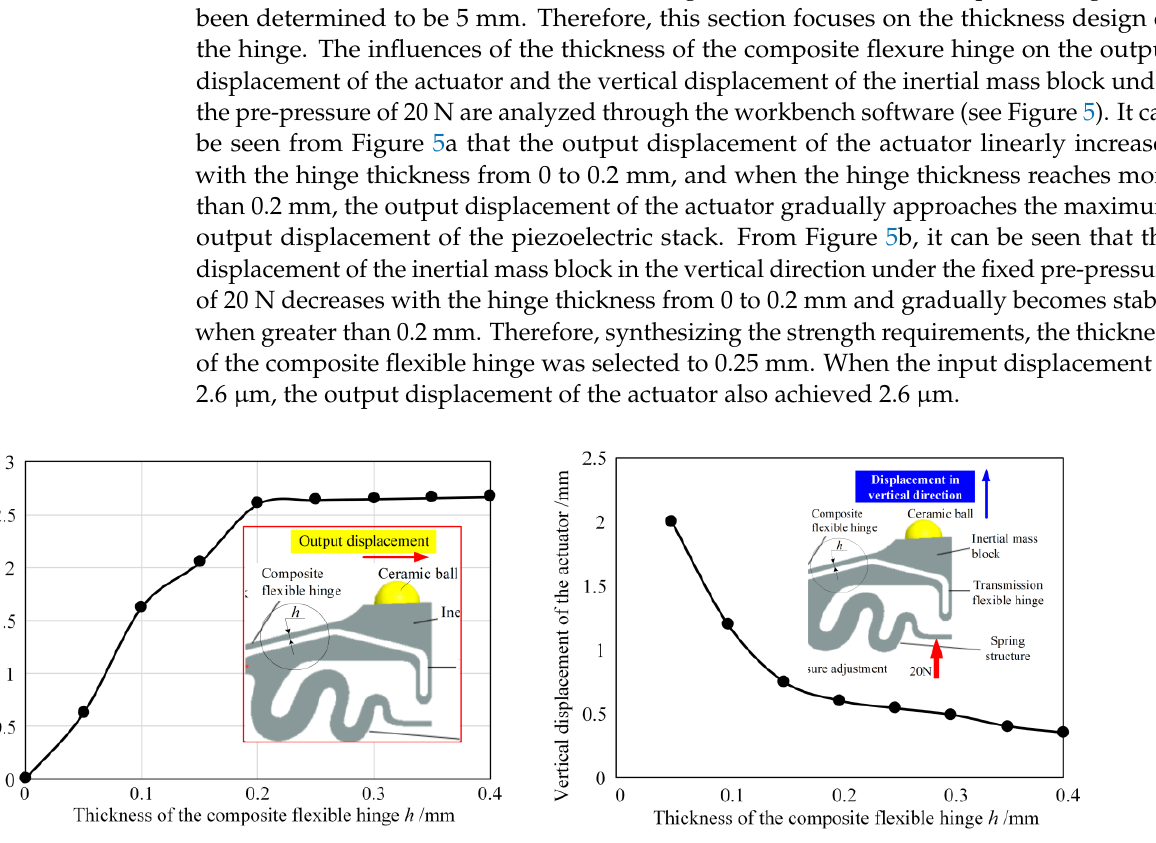
Figure 4. Finite element model of the actuator.